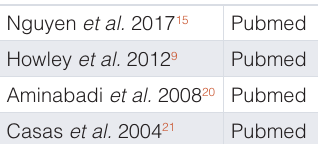
Table 3. List of included